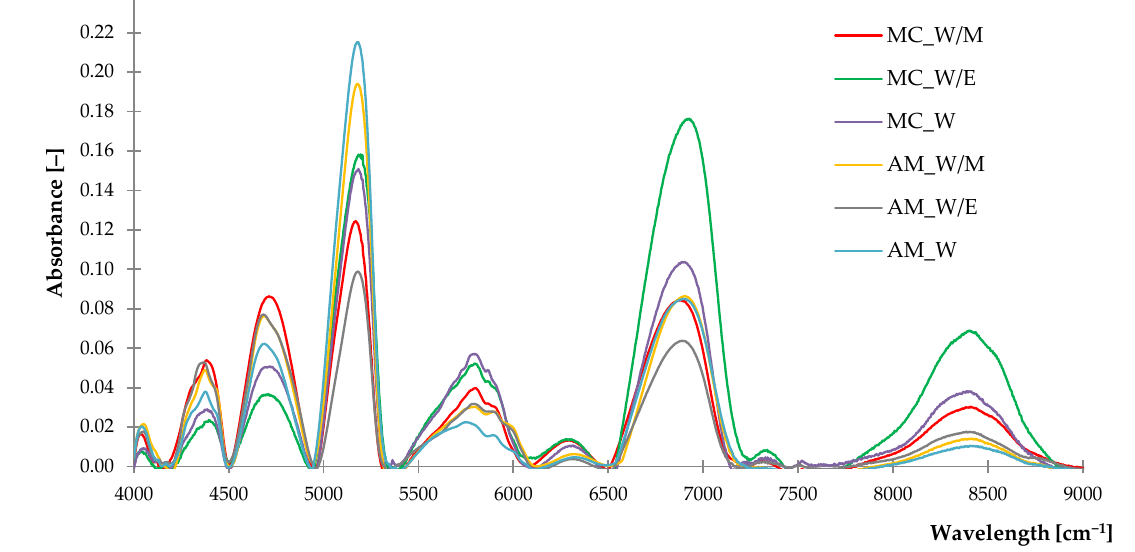
Figure 3. The NIR spectra of freeze-dried extracts. Table 2. Characteristic functional groups registered by NIR analysis. Based on Refs. [59–62]. Peak Assignments and Type of Vibration